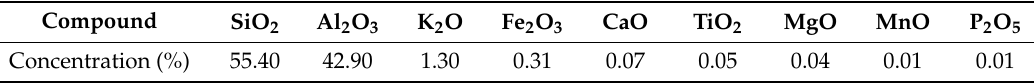
Table 1. Chemical composition of raw clay.